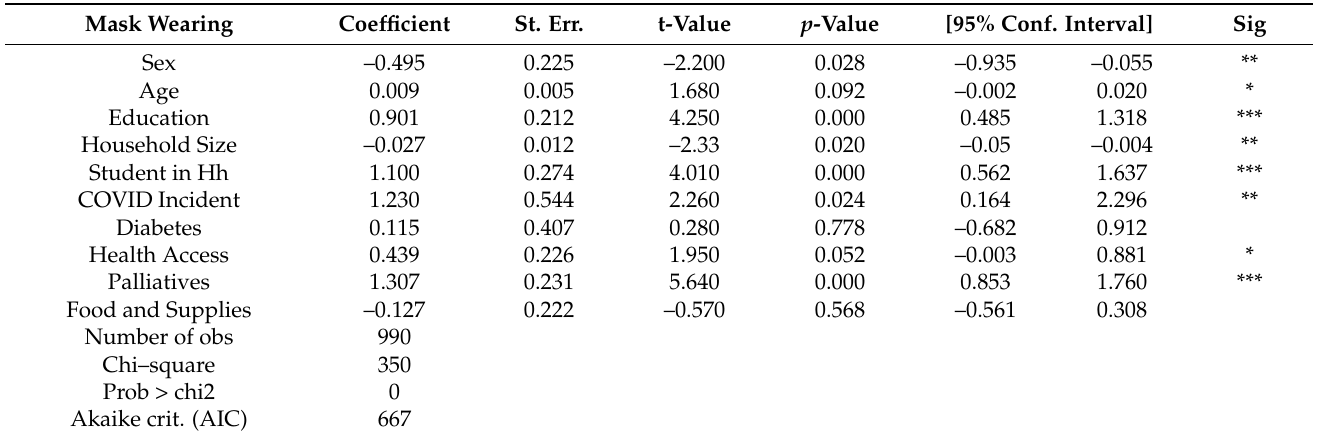
Table 4. Robustness test: Model without constant term. Note—Hh stands for Household